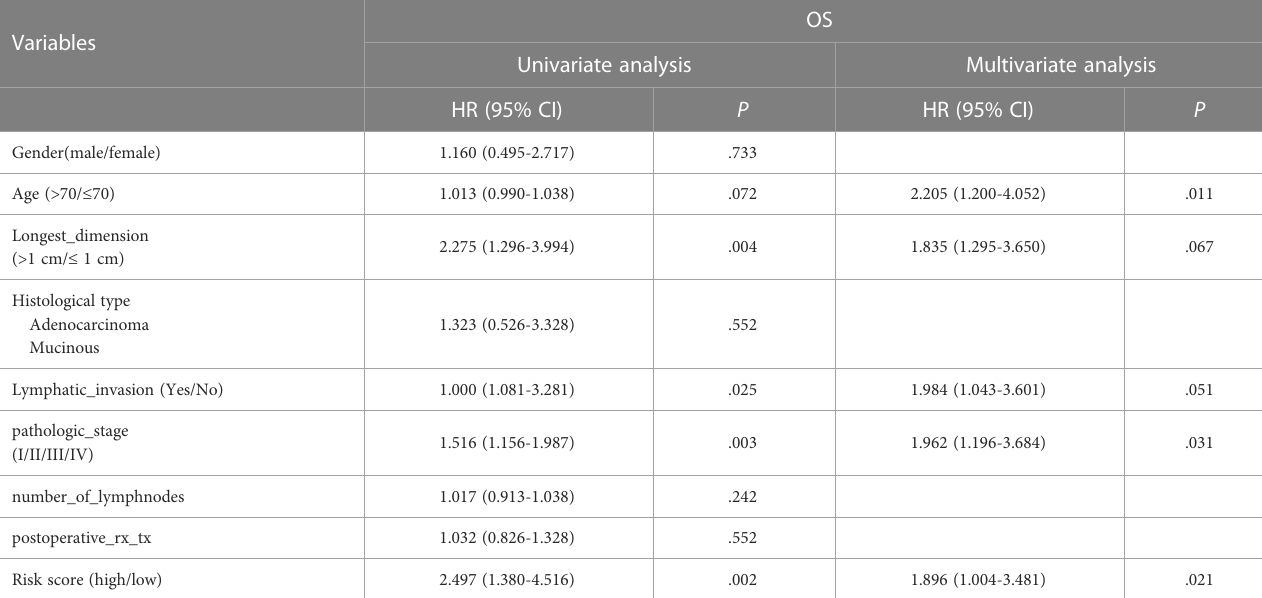
TABLE 3 Cox regression analyses of RS and clinicopathological parameters related to prognosis in CRC